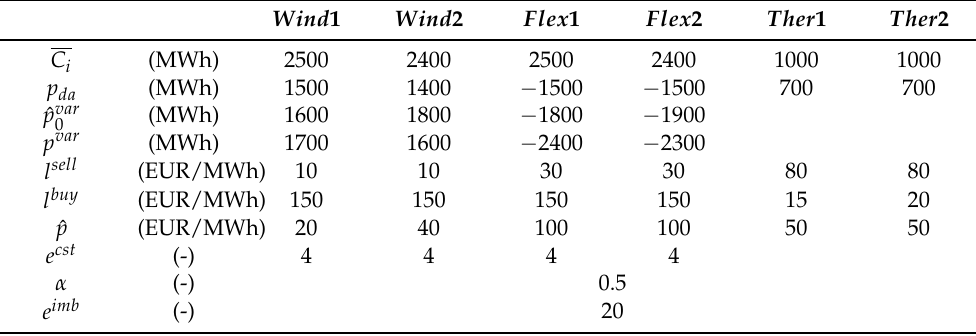
Table 1. Summary of parameters of various trading agents considered in the